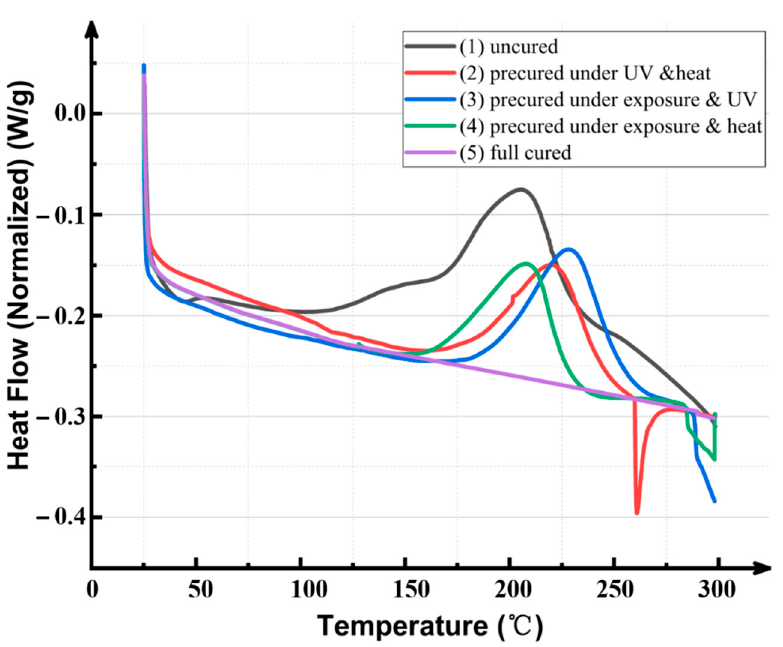
Figure 10. Heating value by different curing conditions measured by DSC on SR3.